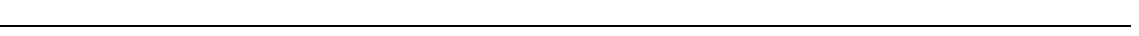
Fig. 4 Measurement of GPC1 mRNA in pancreatic cancer cell-derived EVs and patient serum EVs. a TIRF images of GPC1 mRNA expression in AsPC-1 EVs (upper row, signal) and HPDE6-C7 EVs (bottom row, control) using LN – MB, LN – CHDC, LPHN – MB, and LPHN – CHDC, respectively. b Fluorescence intensity of AsPC-1 EVs (signal) and HPDE6-C7 EVs (control) with the same concentration around 10 8 mL − 1 treated with LN – MB, LN – CHDC, LPHN – MB, and LPHN – CHDC, respectively. c Fluorescence signal ampli fi cation capability of LN – CHDC, LPHN – MB, or LPHN – CHDC relative to LN – MB based on AsPC-1 EV-associated fl uorescence. d Signal-to-background ratios of LN – MB, LN – CHDC, LPHN – MB, and LPHN – CHDC (signal represents fl uorescence intensity of AsPC-1 EVs; background represents fl uorescence intensity of HPDE6-C7 EVs). e TIRF images of AsPC-1 EVs with 10-, 50-, 250-, and 1000-fold dilution detected by LPHN – CHDC. EV concentration for each dilution measured by NanoSight LM10 was ~10 7 mL − 1 , ~2 × 10 6 mL − 1 , ~4 × 10 5 mL − 1 , and ~10 5 mL − 1 , respectively. f Calibration curve for fl uorescence intensity of GPC1 mRNA expression in AsPC-1 EVs using LPHN – CHDC vs. low concentration of EV. The LOD of AsPC-1 EVs with LPHN – CHDC was 57,550 per mL. g Representative TIRF images of GPC1 mRNA expression in serum EVs of discovery